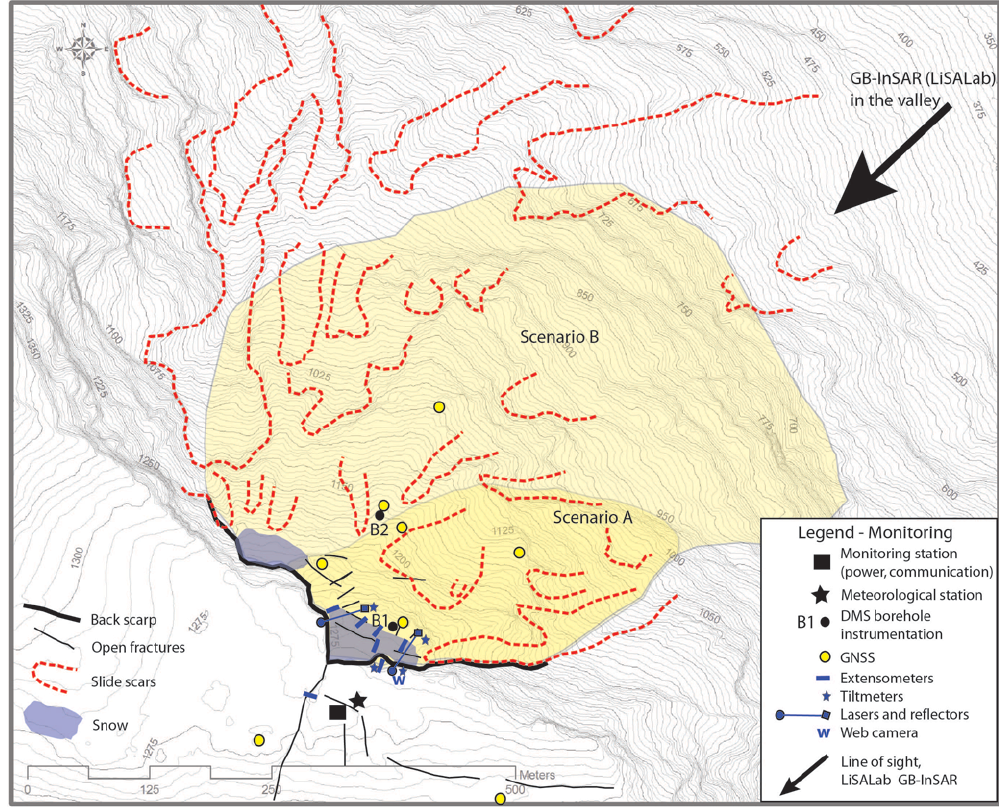
Fig. 5. Mannen rockslide monitoring network. Ground-based in-place instrumentation is concentrated close to the back scarp, while the GB InSAR system is placed in the valley below. Two deep boreholes are instrumented by 120m-long DMS columns. Open fractures and slide scars were identified and mapped during previous field investigations. Theoretical and technical details of those techniques are developed in Stumpf et al. (2011) and Michoud et al. (2012).